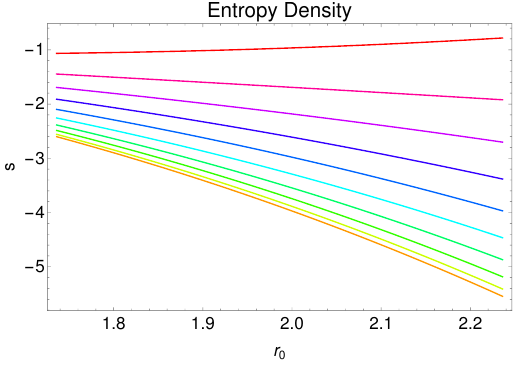
Figure 15 . Entropy of cutoff branes in black hole geometry.